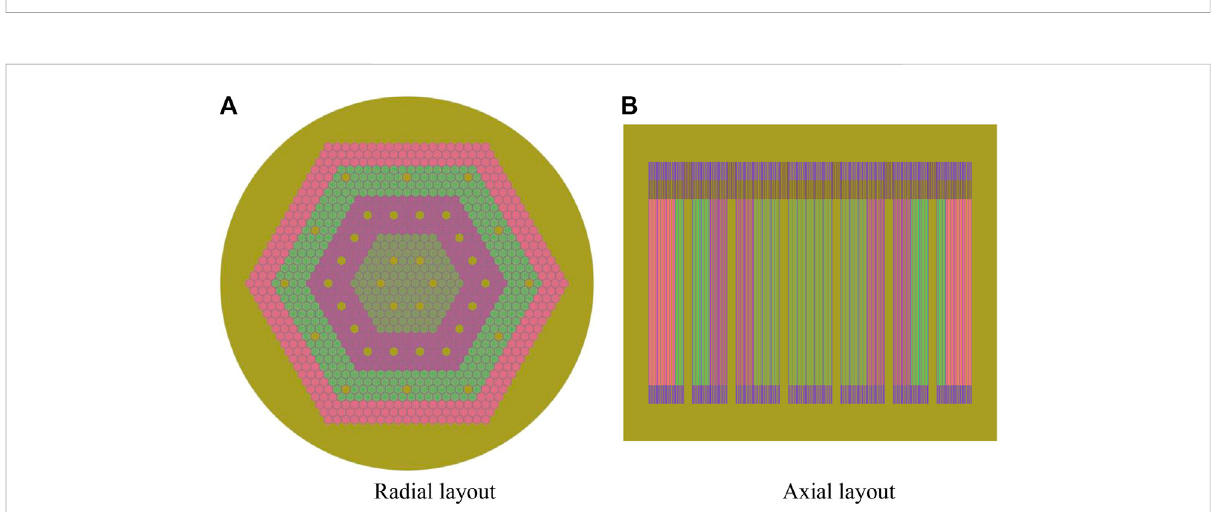
FIGURE 5 700-MWt core arrangement diagrams of UO 2 and U-10Zr: (A) radial layout and (B) axial layout.